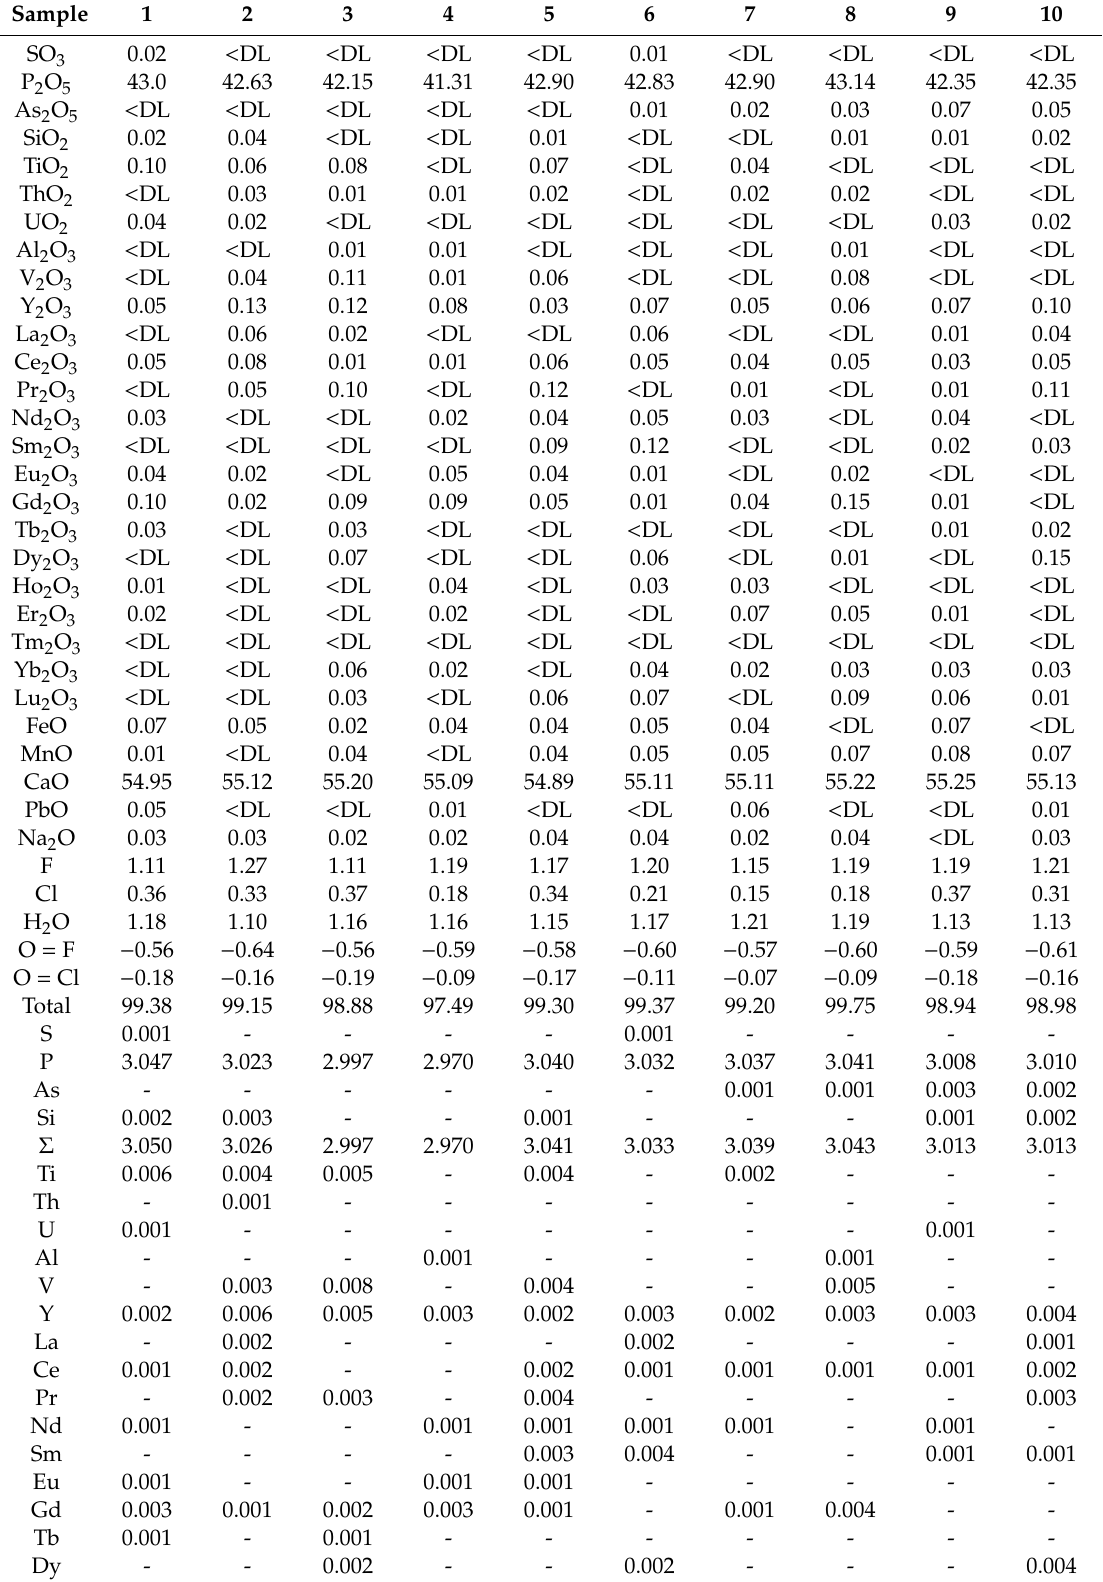
Table 2. Electron microprobe analyses of hydroxylapatite, first provided in wt.% of elements ( < DL—content below the detection limit of respective element) and then recalculated on a basis of eight